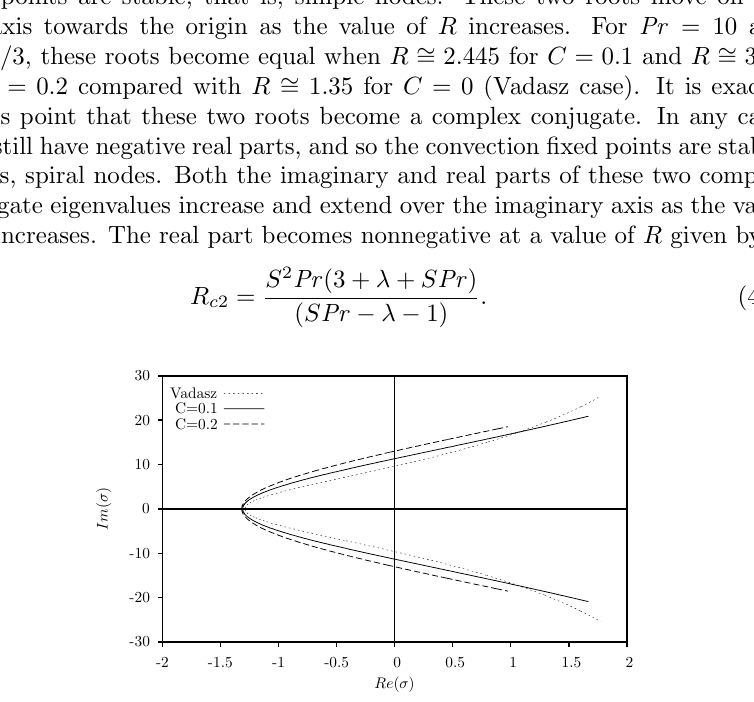
Figure 2. Evolution of the complex eigenvalues with increasing Rayleigh number, for Pr = 10, λ = 8 / 3, Vadasz case, C = 0 . 1 and C = 0 . 2. Relation (4.3) is an extension of R 0 in [17] to the couple stress case C (cid:54) = 0 (i.e. S (cid:54) = 1). At this point, the convection fixed points lose their